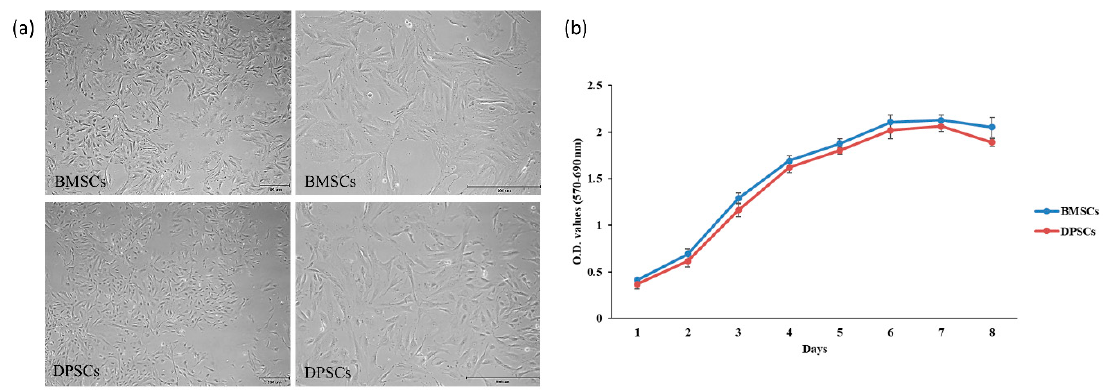
Figure 1. ( a ) Images of BMSCs and DPSCs at passage 3 after 3 days of culture. Images of BMSCs and DPSCs at × 10 and × 40 magnification revealed that both cell types exhibited a healthy fibroblastic morphology typical of MSCs. Scale bars = 200 μ m. ( b ) Proliferation rates of BMSCs and DPSCs. A similar proliferation rate and tendency was found for the two cell types.